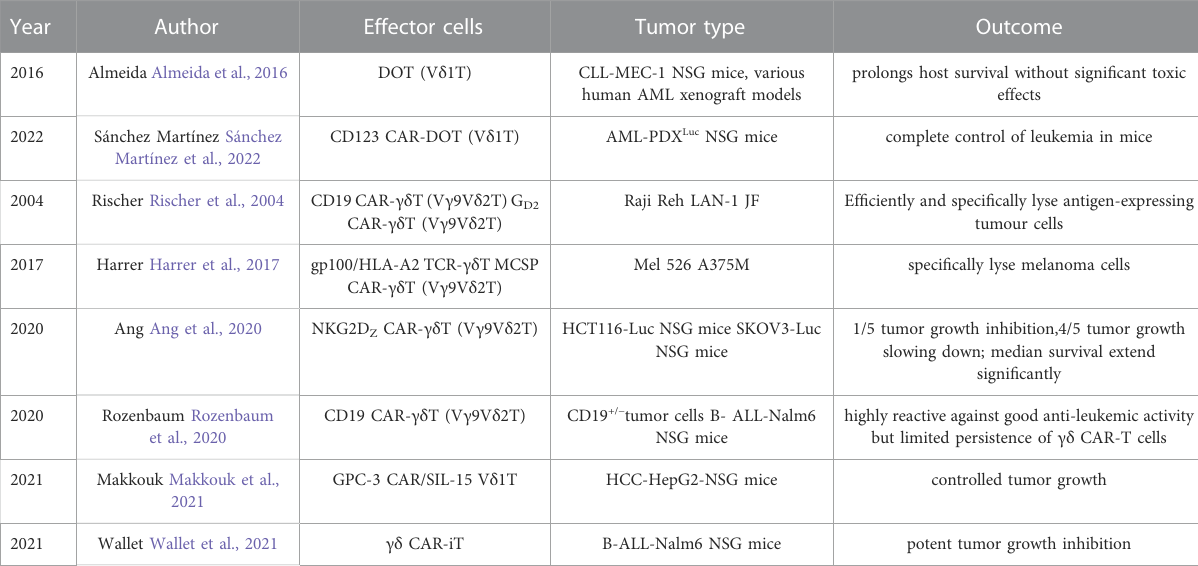
TABLE 1 Preclinical trials based on γδ